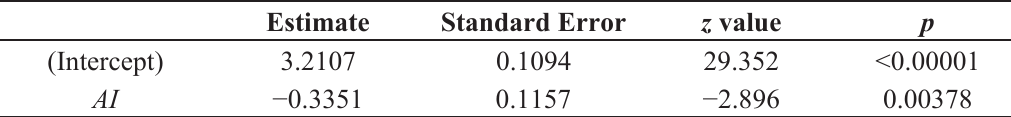
Table 1. Results from negative binomial regression for predicting beetle occupancy based on the aggregation index in